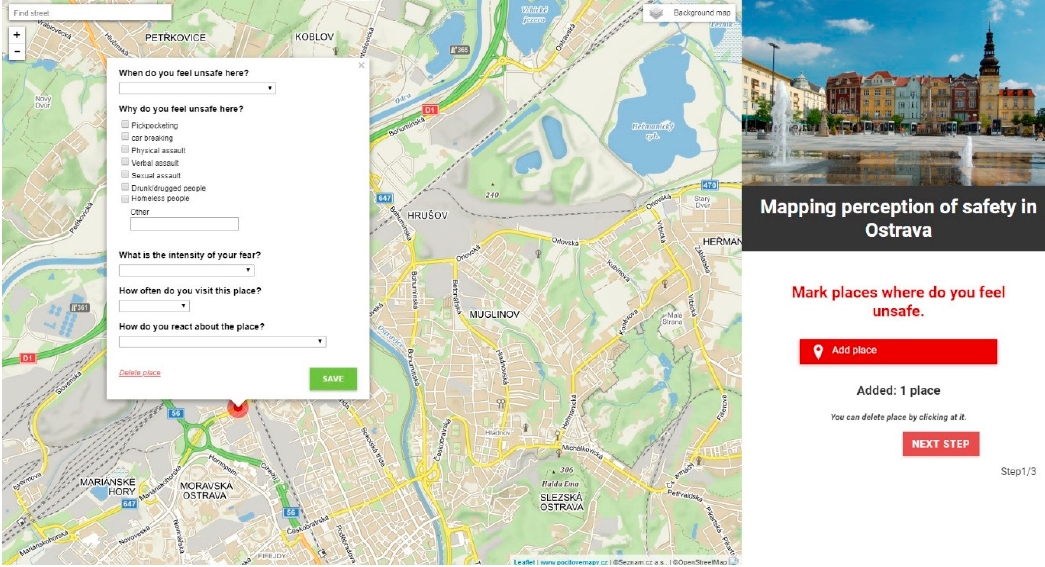
Figure 1. Print screen of the mapping application interface used for data collection.